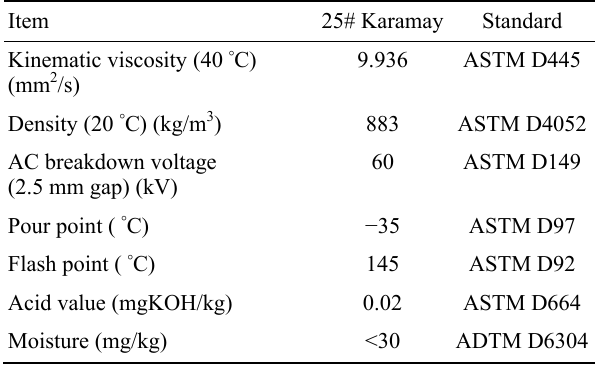
Table 1 Typical characteristics of the naphthenic oil.